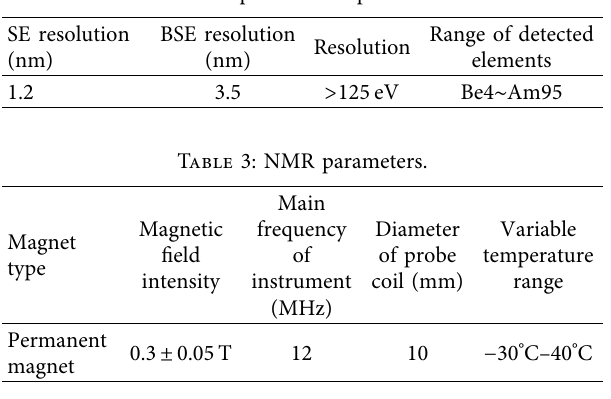
Table 2: Spectrometer parameters.